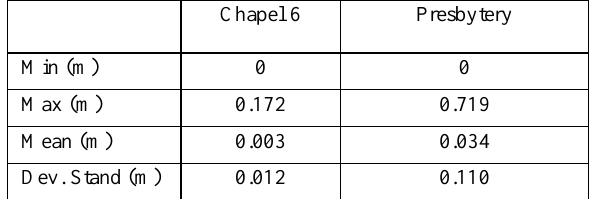
Table 2 . Statistical values of the comparisons between the TLS